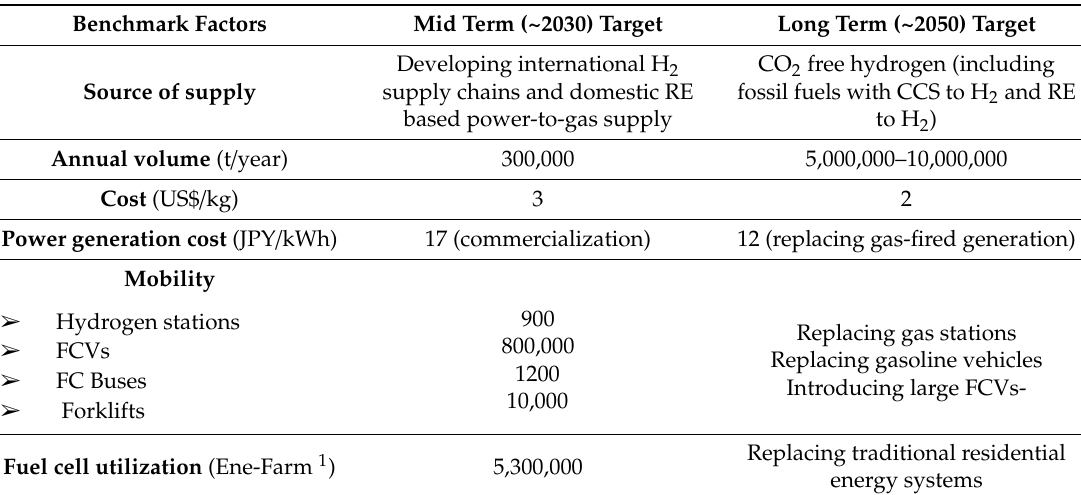
Table 1. Benchmark factors, mid and long-term targets for the Basic Hydrogen Strategy. CCS: carbon capture and sequestration, RE: renewable energy, FCV: fuel cell vehicle.